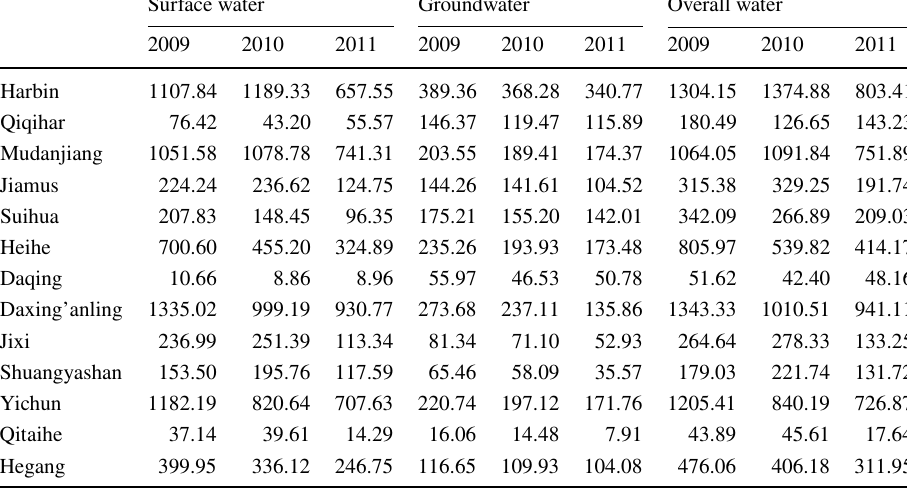
Surface water Groundwater Overall